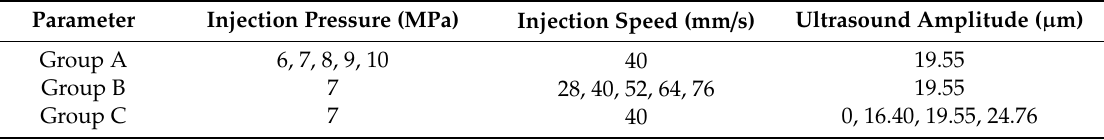
Table 2. Experimental parameters.